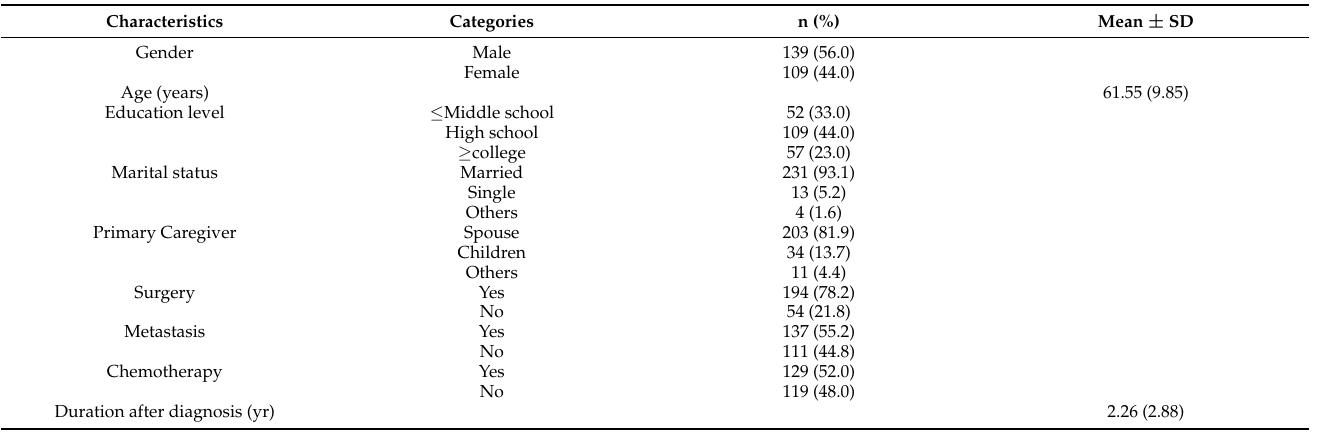
Table 1. General characteristics of the participants (N =